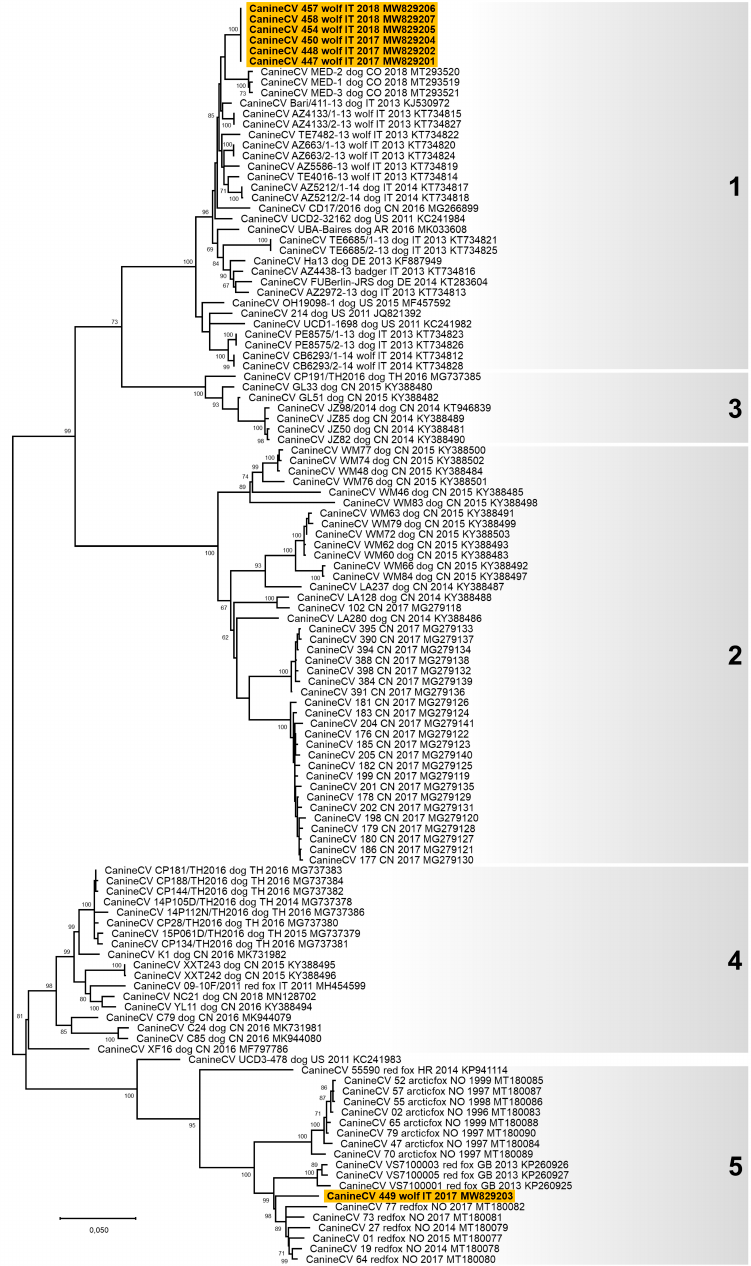
Figure 3. Unrooted phylogenetic tree constructed on the complete genome nucleotide sequences of canine circovirus (CanineCV) obtained in this study and reference strains in the GenBank database (Table S3). Phylogeny was carried out using the Maximum Likelihood method and General Time Reversible (GTR) model with a gamma distribution and invariable sites. The robustness of the individual nodes on the phylogenetic tree was estimated using 1000 bootstrap replicates. Bootstrap values greater than 60% are indicated. The scale bars indicate the estimated number of nucleotide substitutions. Highlighted in yellow: sequences of CanineCV generated in this study. Numbers in black on the right of the figure are the groups evidenced in this study and correspond to the clusters proposed by Niu et al. [60] and Urbani et al.